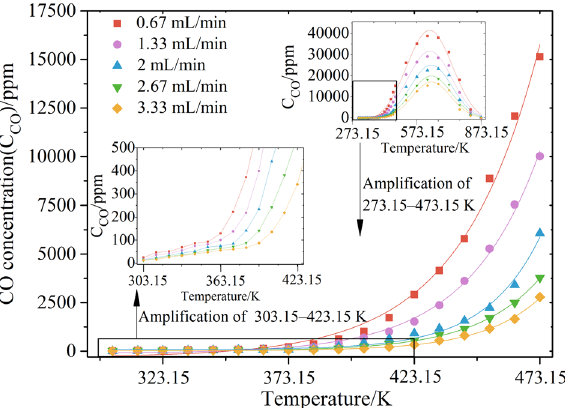
Figure 2. Variation curve of the CO concentration in the spontaneous combustion process of coal samples under different air volume rates.